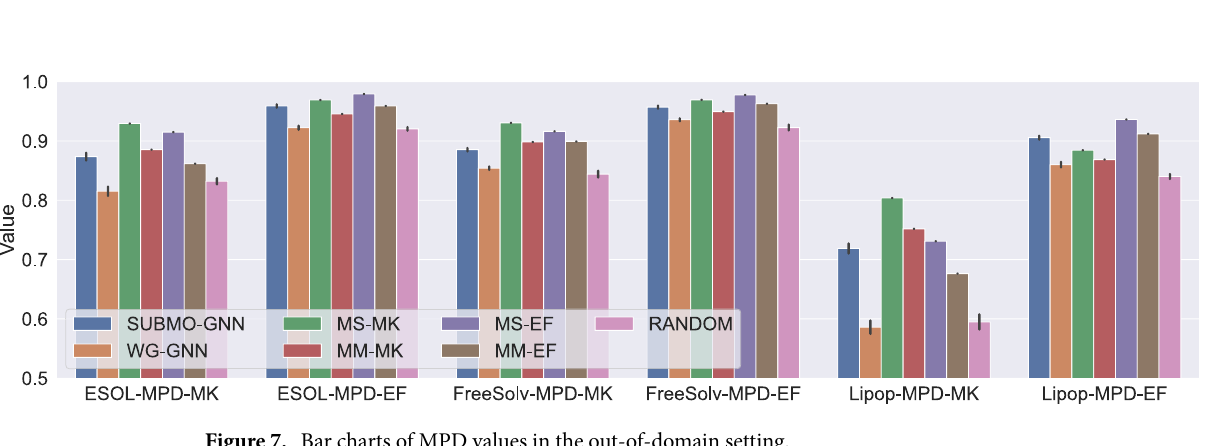
Table 4. MPD values in the out-of-domain setting. For SubMo-GNN, WG-GNN, and Random, means and standard deviations over five trials are shown.